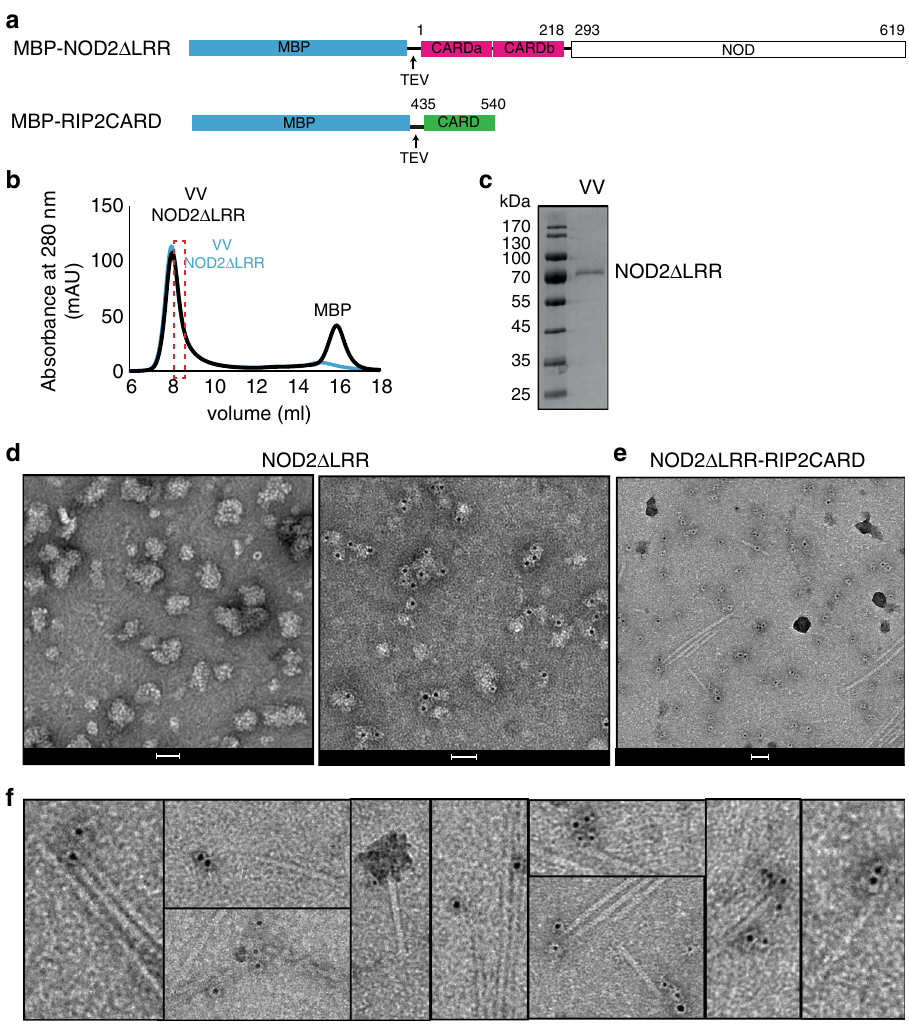
Fig. 4 NOD2 Δ LRR binds RIP2CARD fi laments. a Domain organization of NOD2 Δ LRR and RIP2CARD constructs used for immuno-gold labelling experiments. Expression of recombinant NOD2 Δ LRR was done in sf21 insect cell. b , c Size exclusion chromatography pro fi le ( b ) and ( c ) corresponding 12.5% SDS-PAGE showing typical sample obtained from NOD2 Δ LRR puri fi cation. The size exclusion chromatography pro fi le shows that both tagged (blue) and tag-free NOD2 Δ LRR (black) elute in the VV. The dashed rectangular shape indicated the protein fraction used for immuno-gold labelling experiments. d Negative-stain images of VV NOD2 Δ LRR, corresponding to the fraction used reconstitution with RIP2CARD, unlabelled (left) and after immuno-gold labelling (right). e , f Example negative-stain micrograph of RIP2CARD fi laments with NOD2 Δ LRR bound ( e ) and zoom showing gold-particles (black dots) after immuno-gold labelling against NOD2 ( f ). Scale bars are 50 nm. VV: size exclusion chromatography void